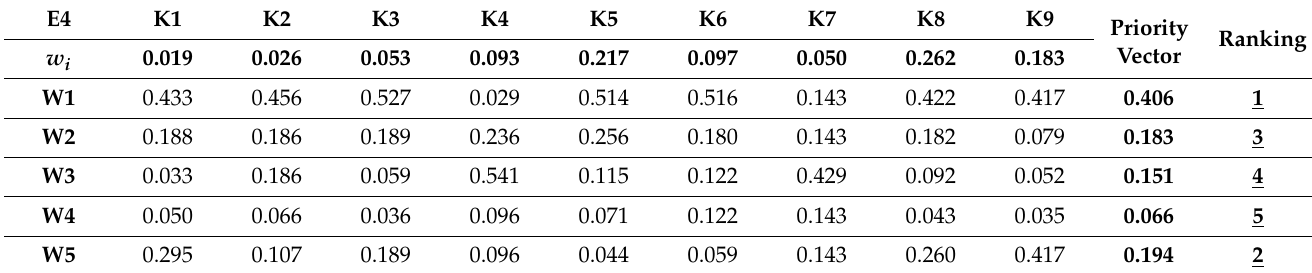
Table 6. Ranked list of the final weight distributions of the respective equipment variants according to Expert 4.